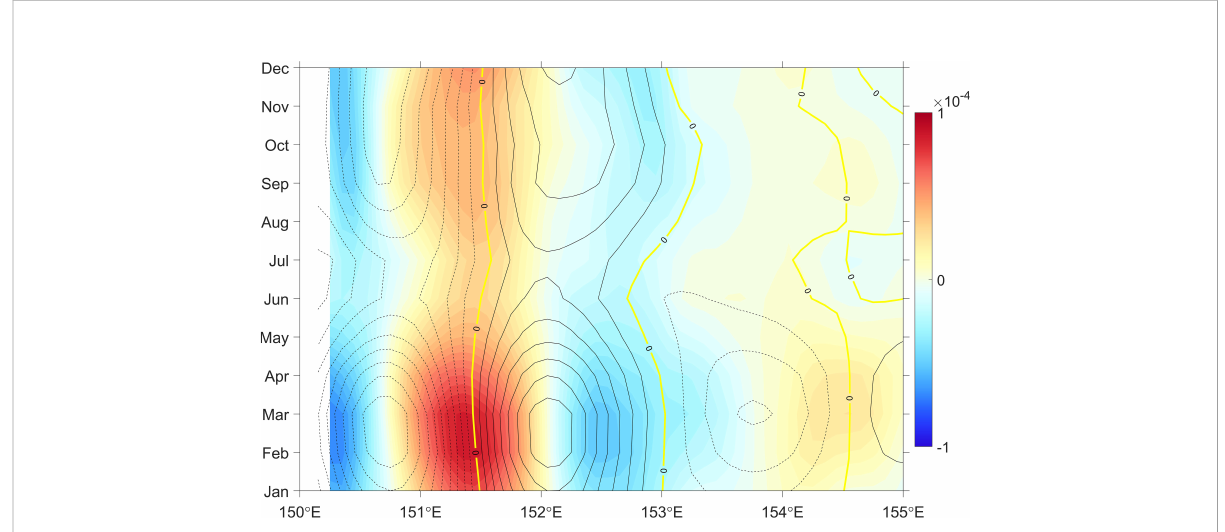
FIGURE 10 Seasonal variability of ∂ (cid:1) v ∂ x (shaded color), and (cid:1) v (contour with 5 intervals, units: cm s -1 ) along 38°S averaged over the upper 300 m layer from OFES during July 1999-October 2009. Solid (dash) lines represent positive (negative) meridional velocity.